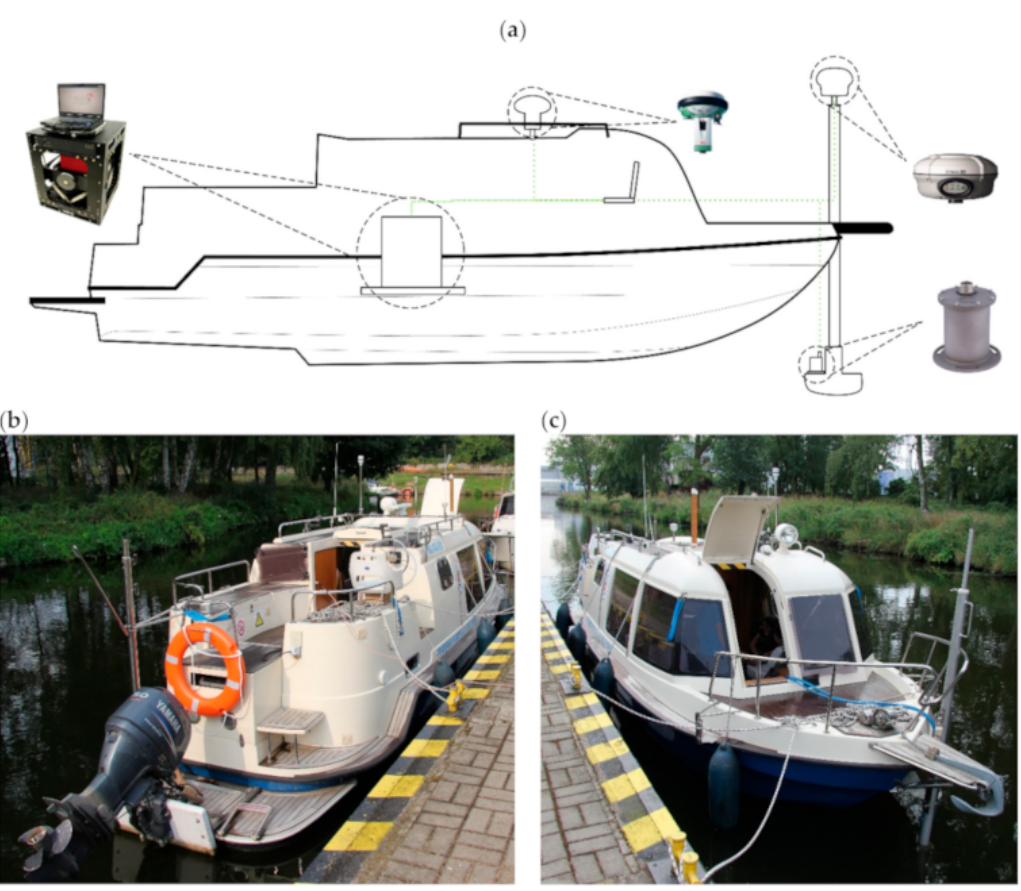
Figure 2. ( a ) Locations of the sensors on the research vessel, from left to right: MGS-6, GS 15, R8 and IMU-10. ( b ) The research vessel during preparation for the campaign: view from stern; ( c ) view from